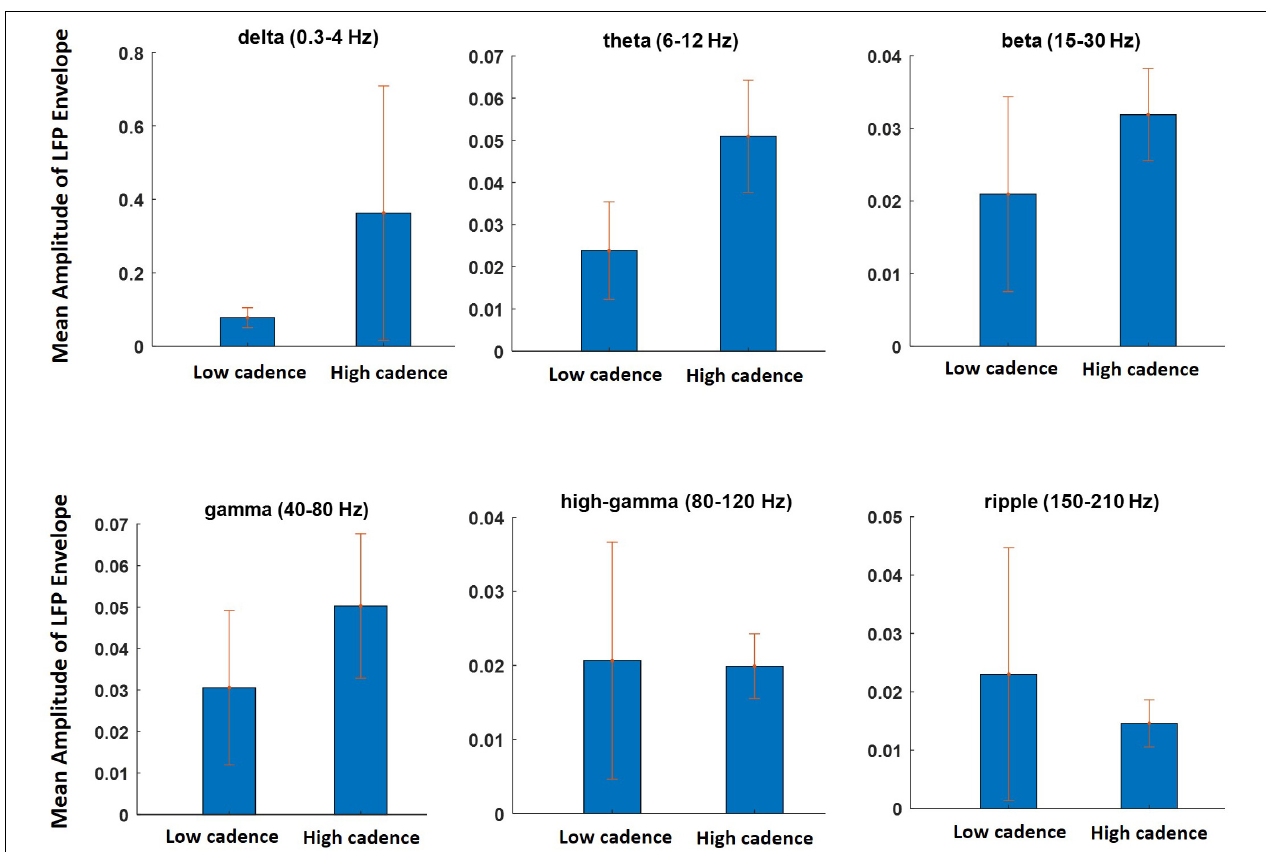
FIGURE 10 | The effect of walking cadence on the mean amplitude of LFP envelope at various frequency bands during movement on the treadmill. The sessions on which animal walking cadence was between 0.59 and 0.67 steps per second were considered as lower cadence category while sessions with cadence between 0.73 and 0.8 steps per second considered as higher cadence